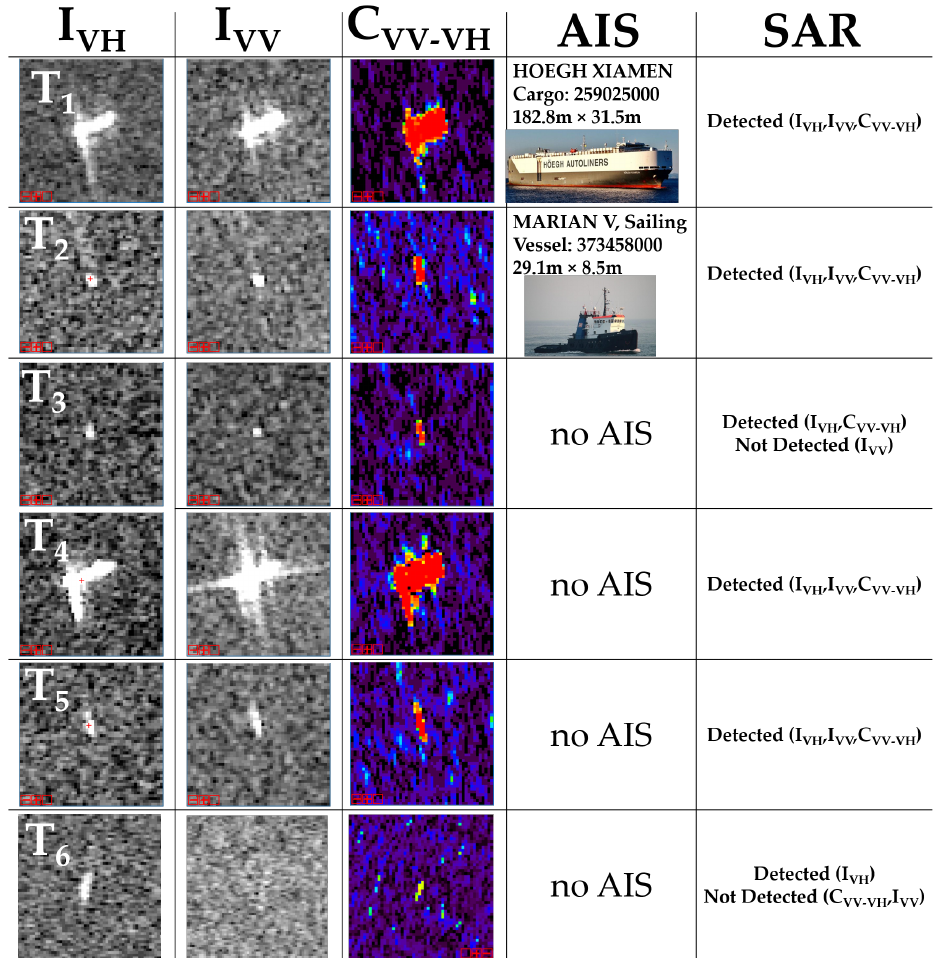
Figure 8. Different Sentinel-1 SAR vessel signatures represented in the C un − norm